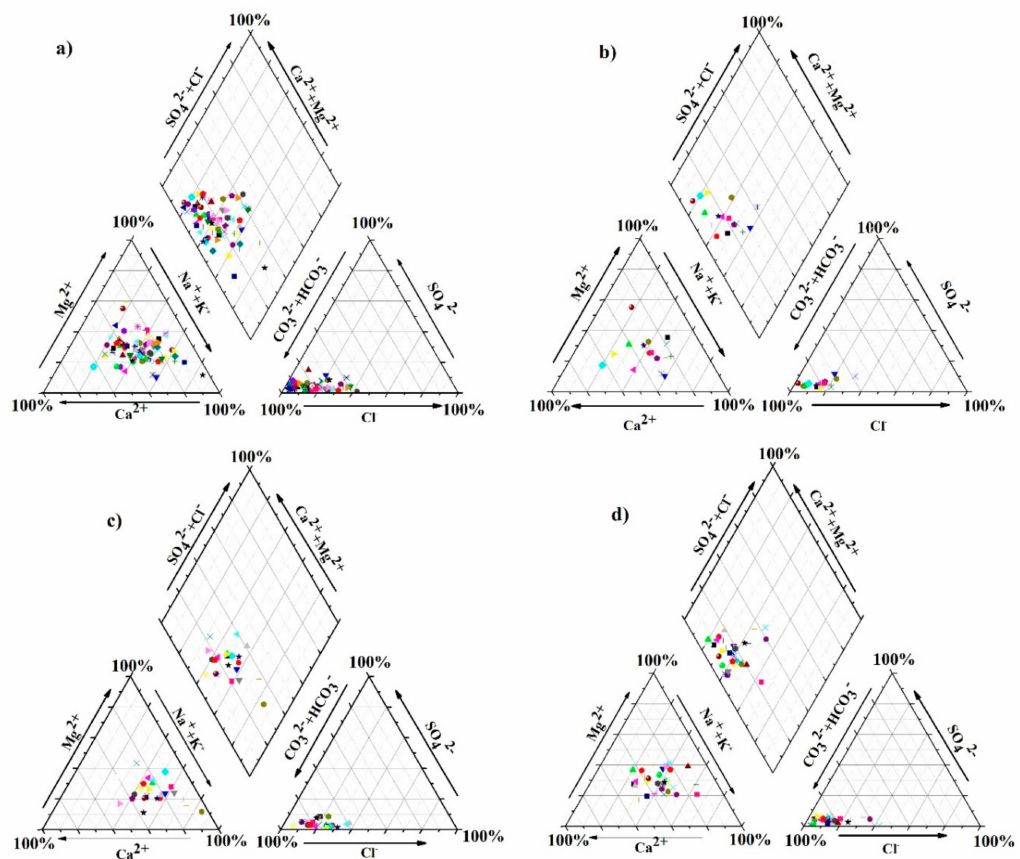
Figure 2. Piper trilinear diagrams showing the di ff erent chemical types of groundwater in wet season: ( a ) all samples, ( b ) samples of mild chronic kidney disease of unknown etiology (CKDu) prevalence areas, ( c ) samples of moderate CKDu prevalence areas, and ( d ) samples of high CKDu prevalence areas. In all zones, the fluoride concentrations ranges from 0.2 mg / L to 6.0 mg / L; when compared